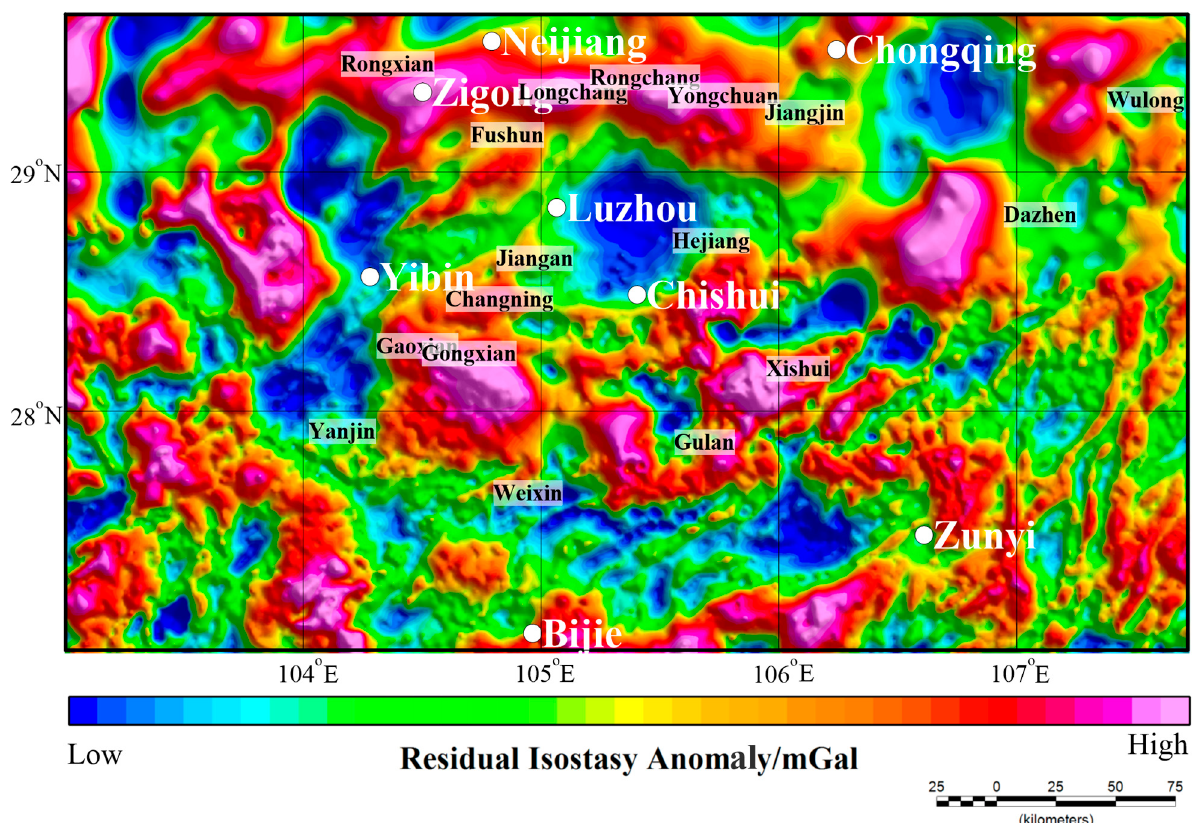
Figure 7. The map of residual isostatic gravity anomaly map.